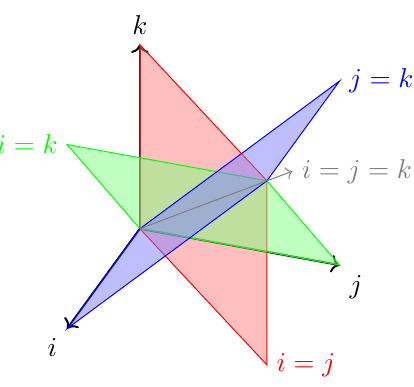
Figure 3 . Sketch of the positive octant of Z 3 cut into six pieces by the planes f i = j g ; f i = k g ; f j = k g